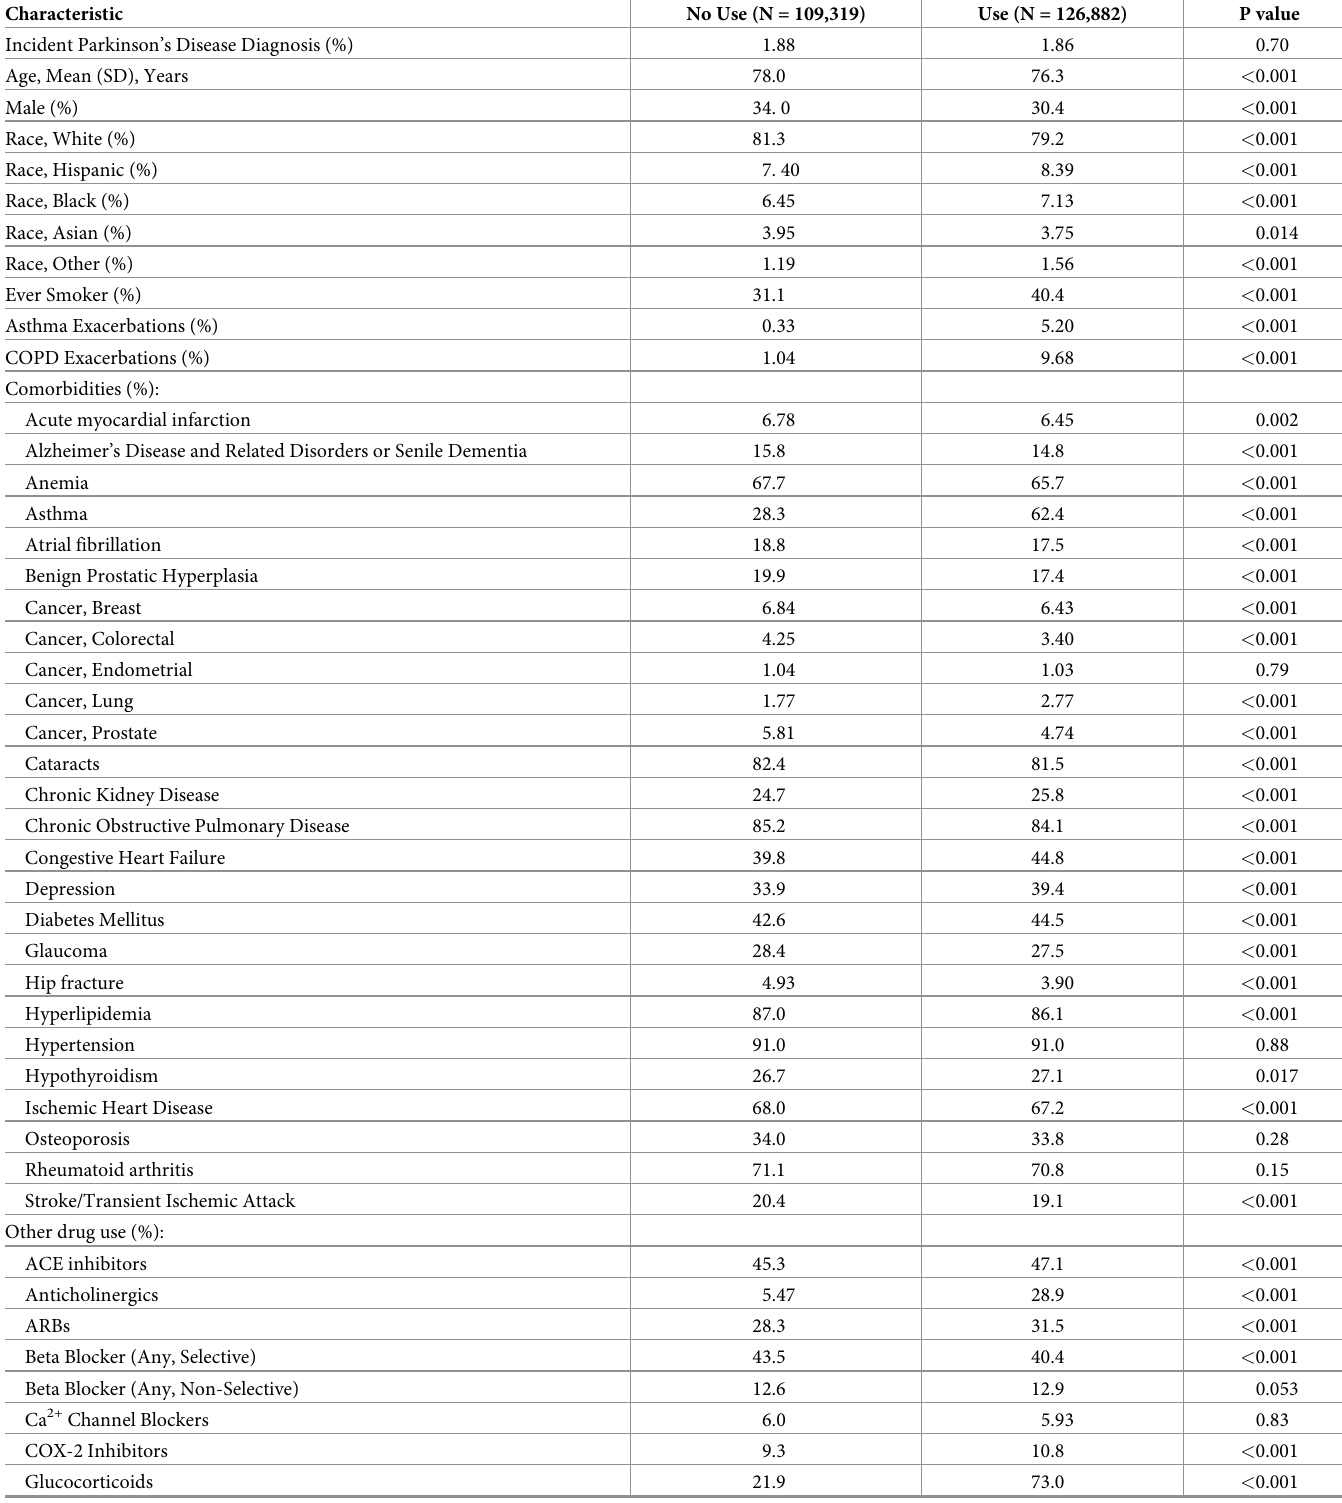
Table 2. Descriptive statistics by β 2-agonist